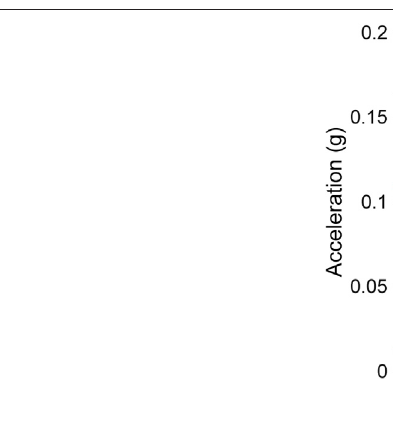
FIGURE 11 | Relationship between acceleration and thickness of compacted